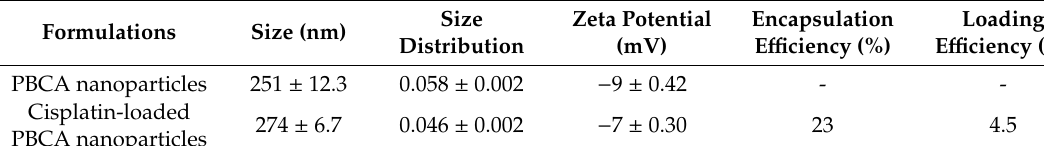
Figure 2. ( A ) scanning electron microscopy SEM and ( B ) transmission electron microscopy TEM images of cisplatin-loaded PBCA nanoparticles prepared using miniemulsion polymerization method (×15,000). Table 1. Size, size distribution, and zeta potential of blank and cisplatin-loaded PBCA nanoparticles and encapsulation and loading efficiencies of cisplatin-loaded PBCA nanoparticles.